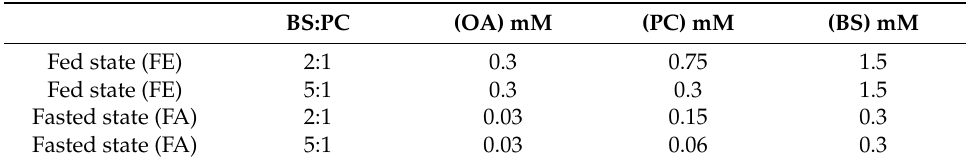
Table 1. Lipid concentrations and BS/PC ratios used for quercetin uptake into Caco-2/TC7